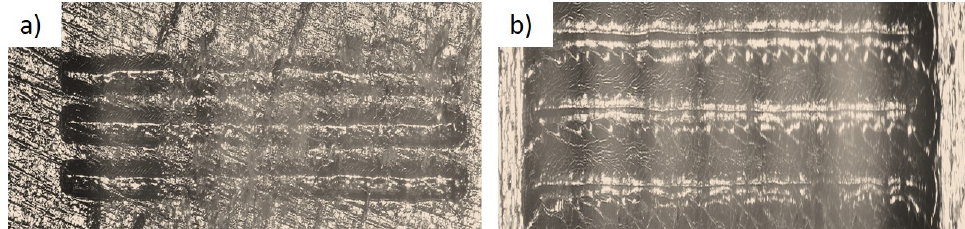
Figure 16. Scratch test for the electroless plated PETG+MWCNT specimen ( a ) under the scratch test machine, microscopic view, and ( b ) expanded view under the scratch tester.